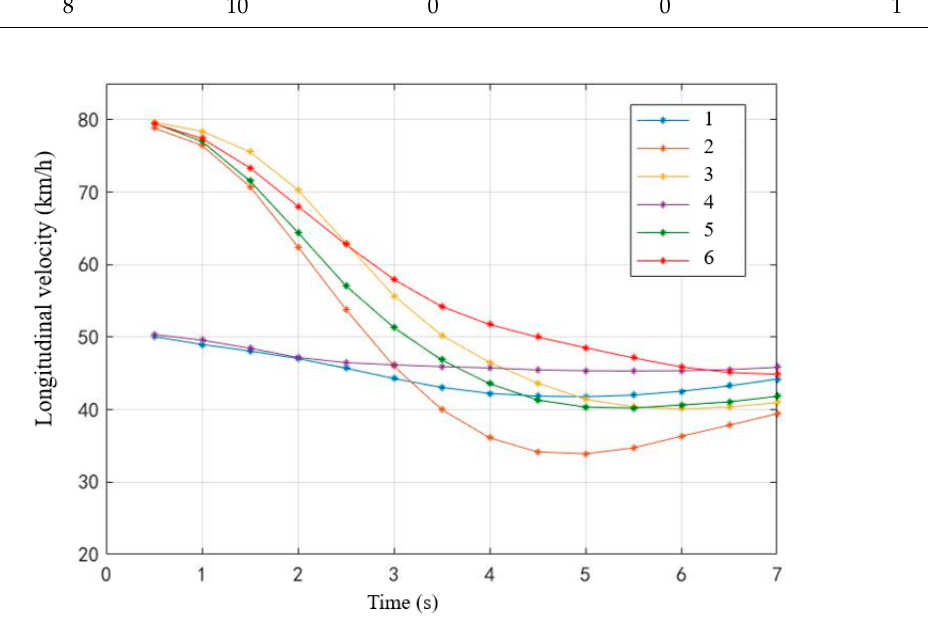
Figure 13. Change curve of mean velocity within 7 s after taking over.